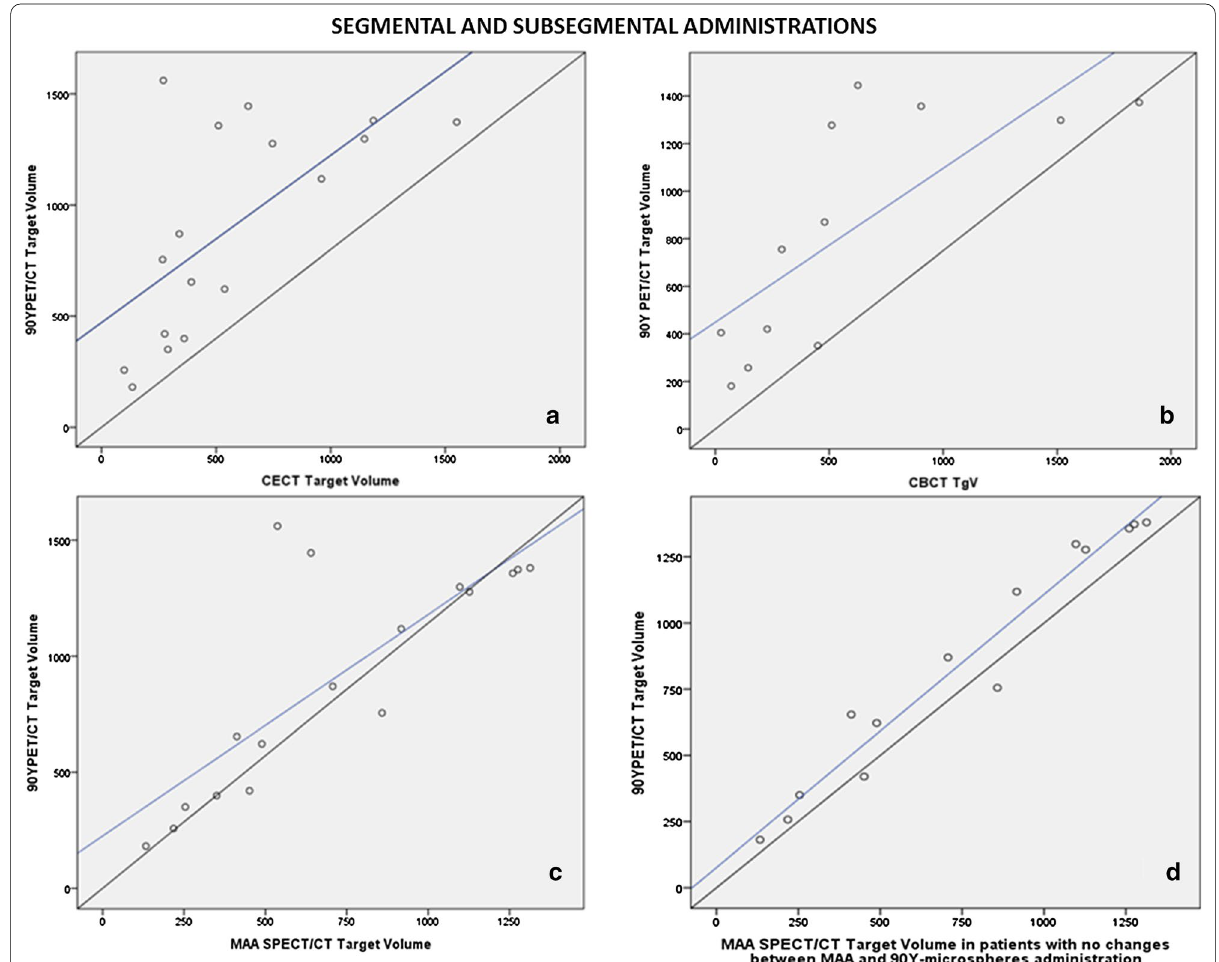
Fig. 3 Correlation (blue lines) between the target volume obtained with 90 Y PET/CT and CECT ( a ), CBCT ( b ) and 99m Tc‑MAA SPECT/CT ( c ) in patients with segmental and subsegmental administrations. When patients with changes between 99m Tc‑MAA and 90 Y‑microspheres administrations were excluded, 99m Tc‑MAA correlation slightly improved ( d ). Diagonal black line indicates perfect correlation between both